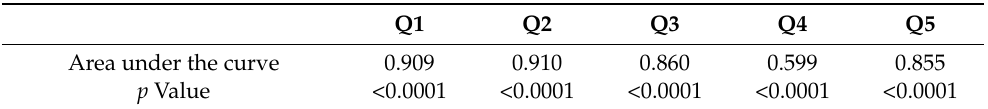
Figure 2. Receiver operating characteristic (ROC) curve to determine how well the scores for each ACT questionnaire item distinguished between groups (Group 1) in which asthma symptoms were not well controlled. Table 4. Asthma control test analysis of diagnostic power in groups (Group 1) where asthma symptoms are not well controlled for each questionnaire item.